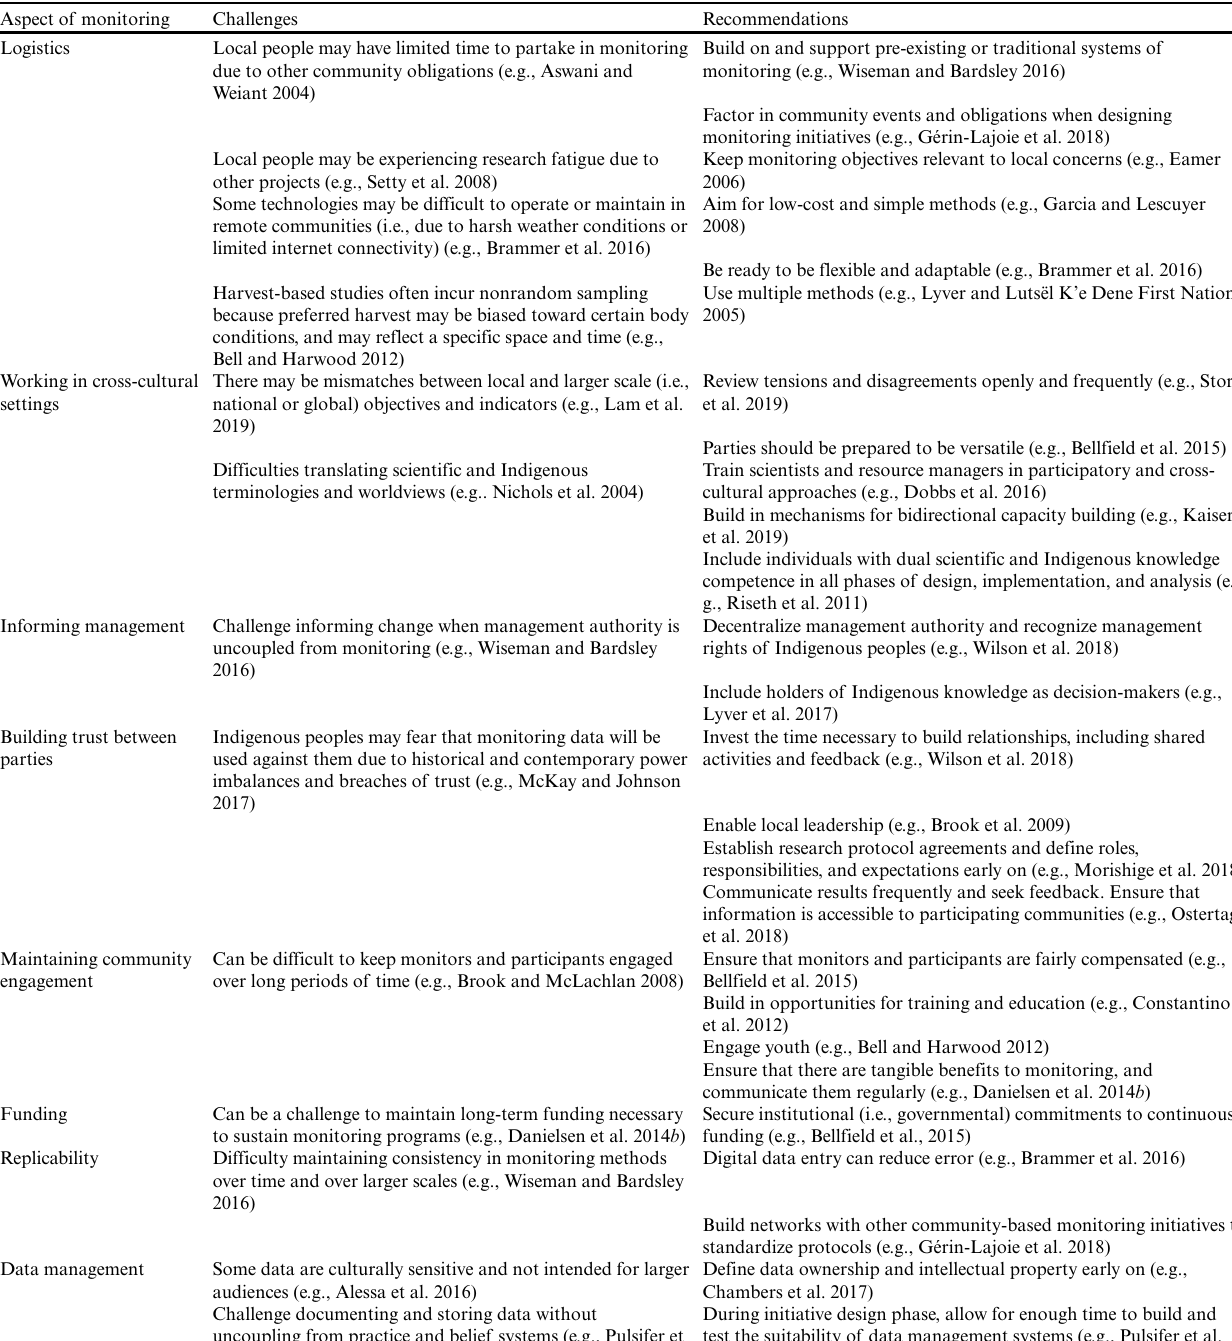
Table 5 . Challenges and associated recommendations discussed in the literature